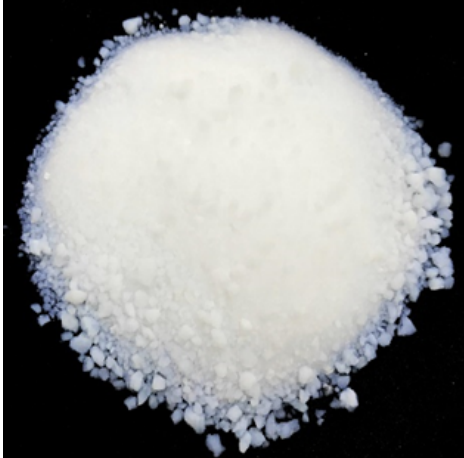
Figure 4. Photography of silica-based